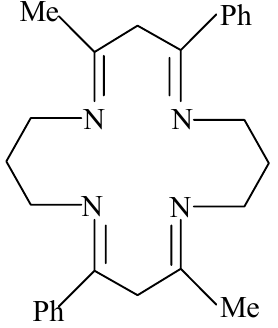
Ph (16)tetraene N ] and their 2 2 4